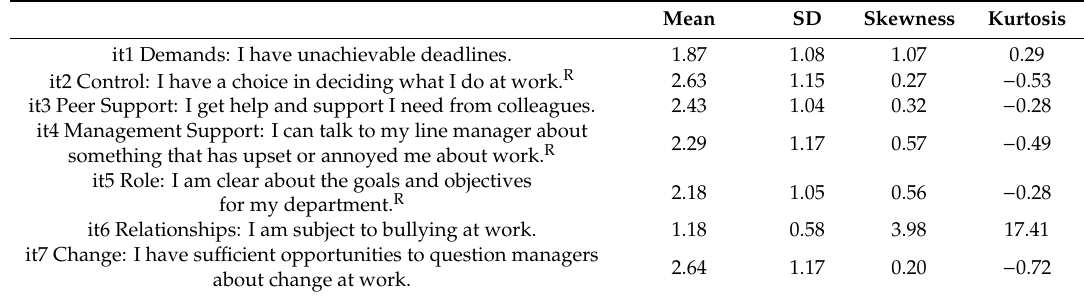
Table 2. Descriptive statistics for the items of the study measure. Mean SD Skewness